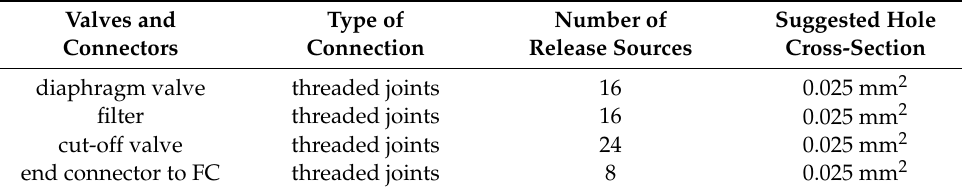
Table 2. Release sources statistics of fuel cell